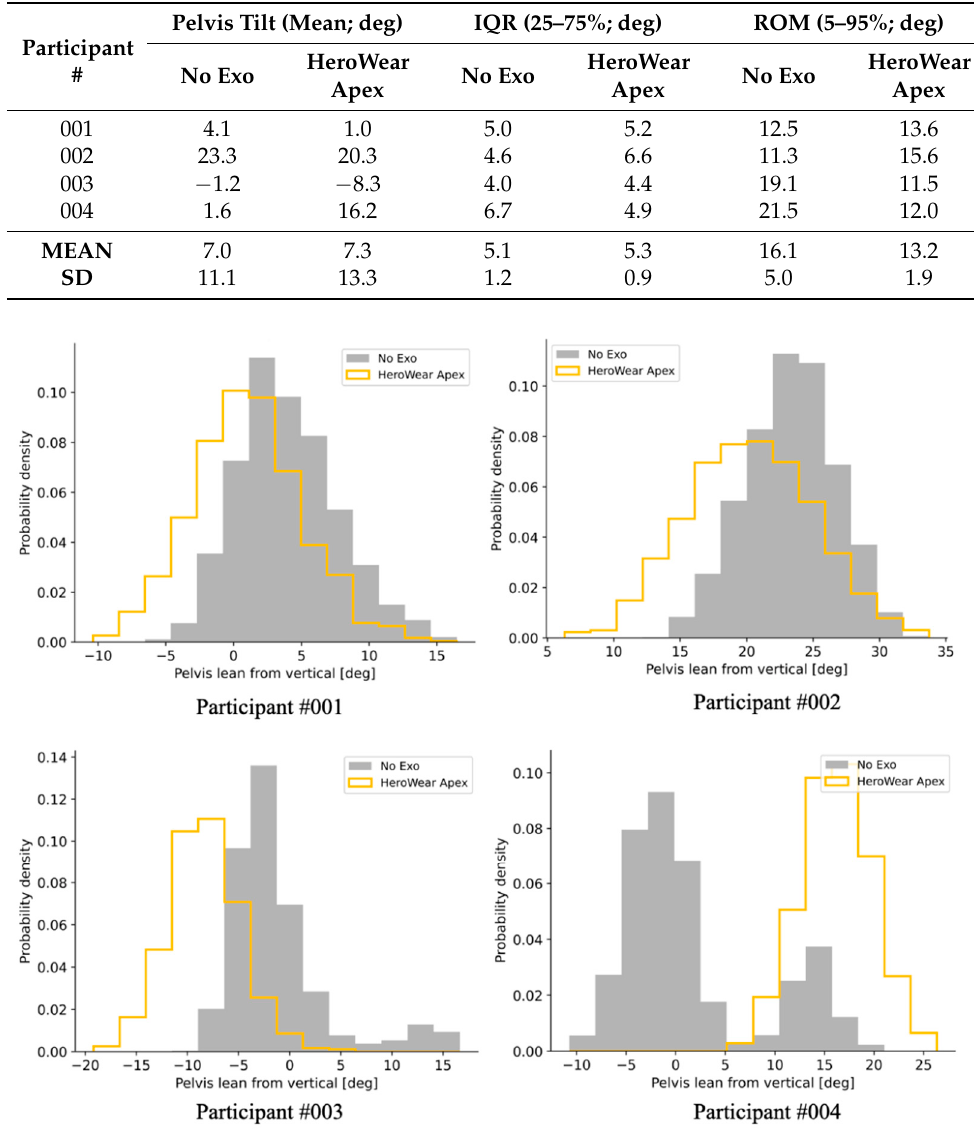
Figure 6. Histograms of pelvis lean from vertical for pushing the unloaded gondola downhill. Table 4. Pelvis tilt (deg) for pushing the loaded gondola at level ground.